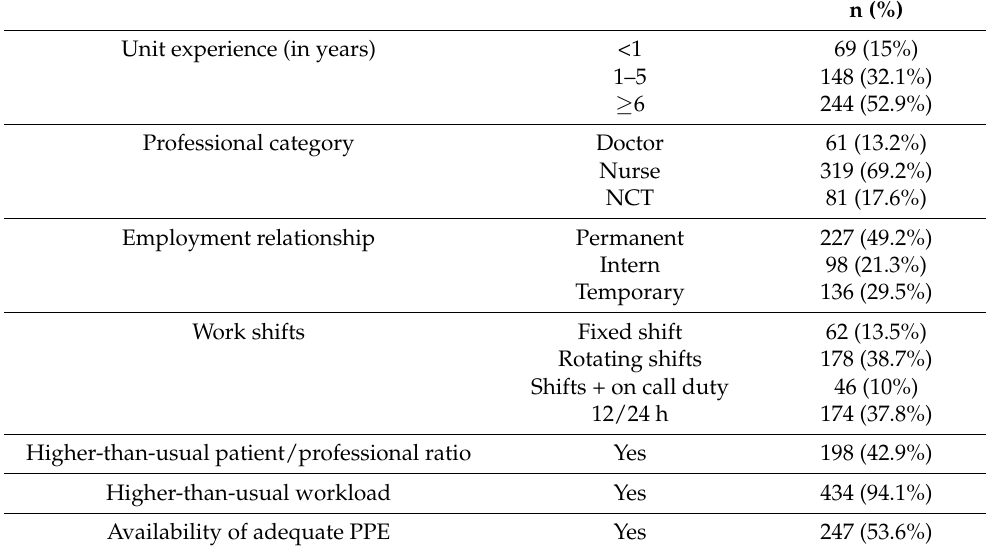
Table 2. Employment characteristics of the sample.